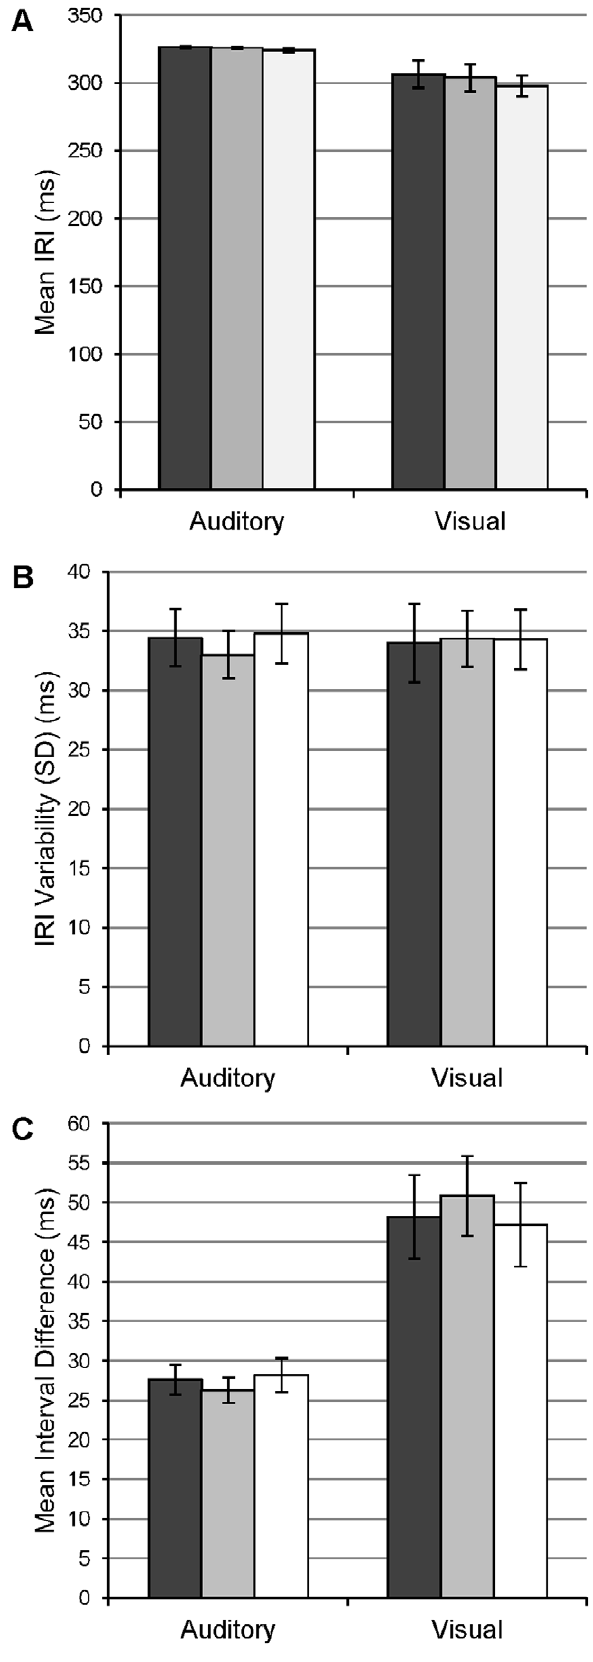
Figure 2. Effect of stimulus modality on finger tapping accuracy. Behavioural data across the three trials (bars: trial 1 - dark grey, trial 2 - light grey, trial 3 - mid grey)) within the two stimulus modalities. Data presented are (A) mean IRI, (B) IRI variability and (C)